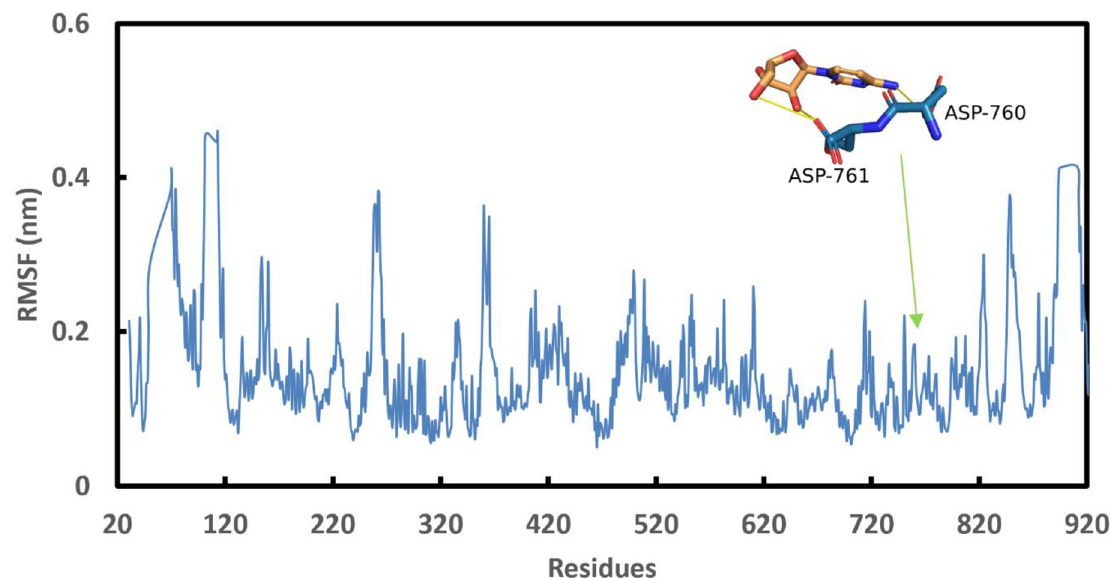
Fig 5. Graphs depicting the average RMSF per residue throughout the course of a 19-ns RdRp simulation.